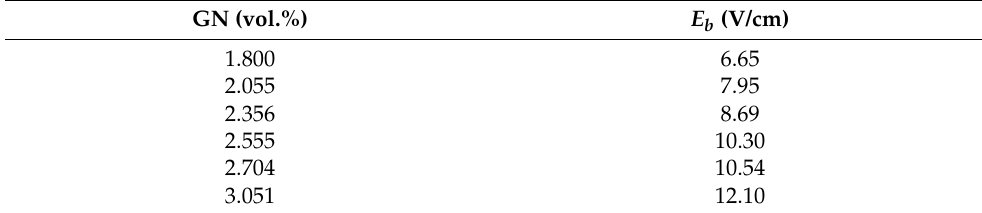
Table 8. Switching field for GNs/epoxy composites [73]. GN (vol.%)